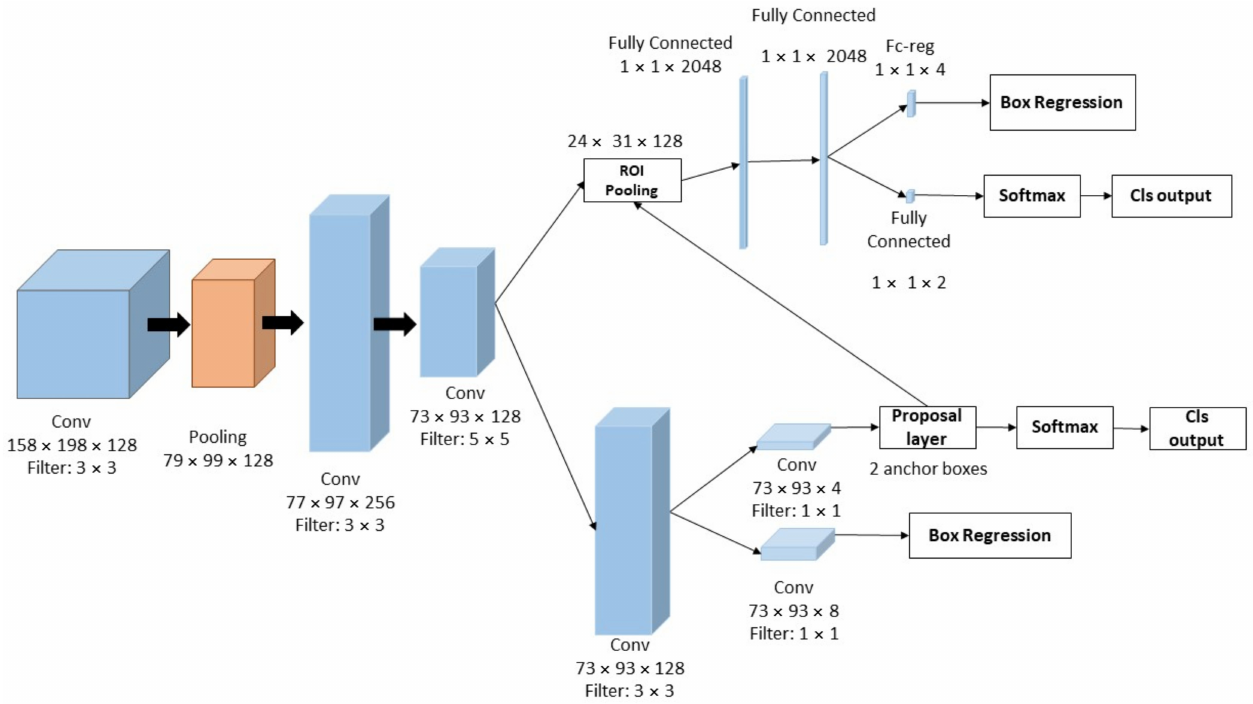
Figure 2. D-CNN for the detection of five body parts. The proposal layer provides bounding boxes (ROI) for the ROI pooling to feed forward to its following CNN, which functions as a